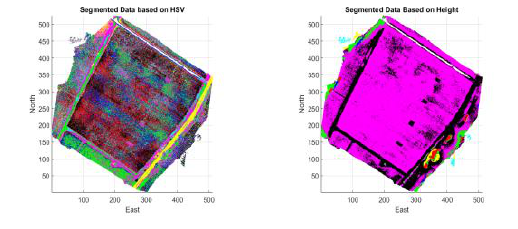
Figure 5: Outcome of Lloyd's classification, colour-coded (left) by HSV and (right) height (k = 7). Each colour represents elements of the DPC identified with each separate cluster. Each of the seven colours in the two images show points associated with each of the clusters.